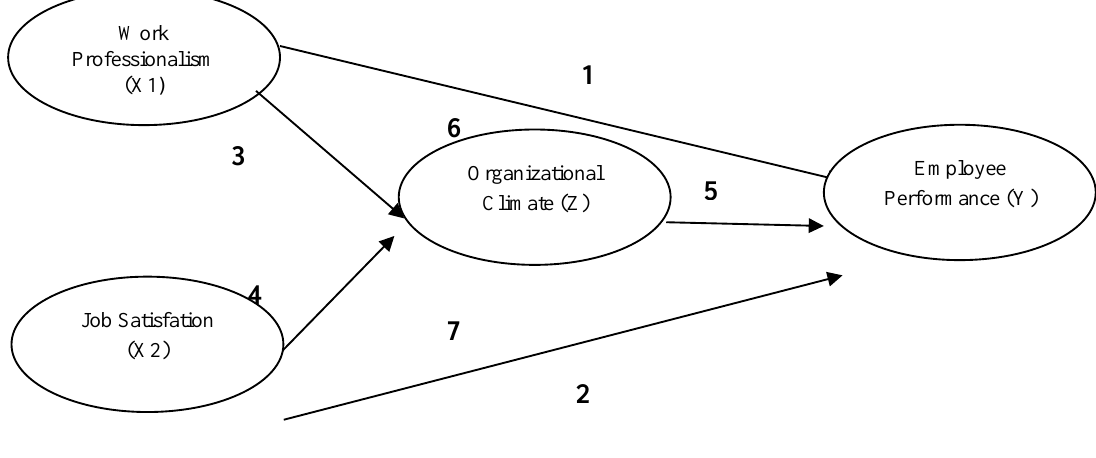
Figure 1: Conceptual Model of the Study; Source : Authors